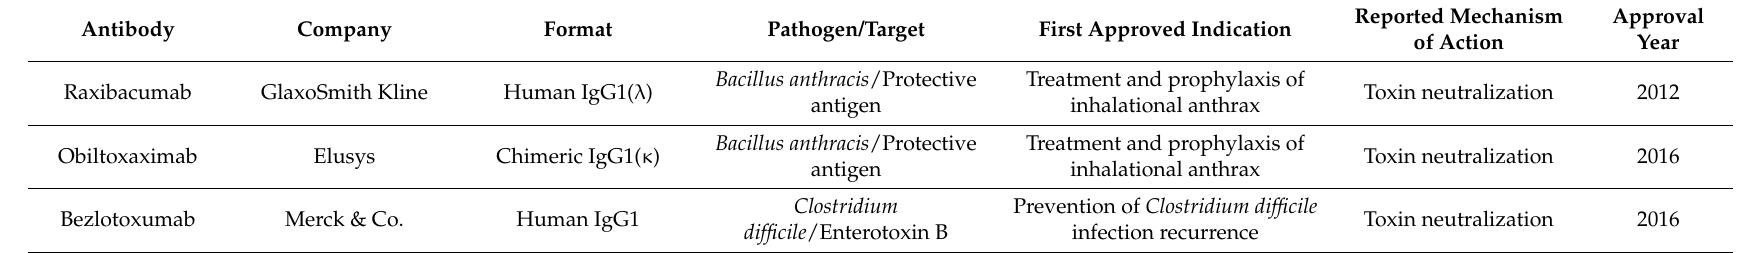
Table 1. Food and Drug Administration (FDA)-approved monoclonal antibodies (mAbs) for use in bacterial infection.